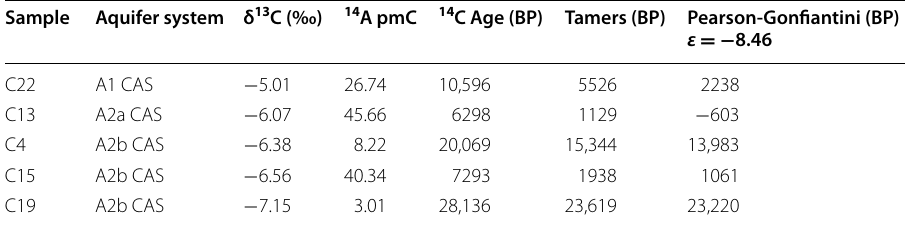
Table 3 14 C ages water confined aquifer systems Sample